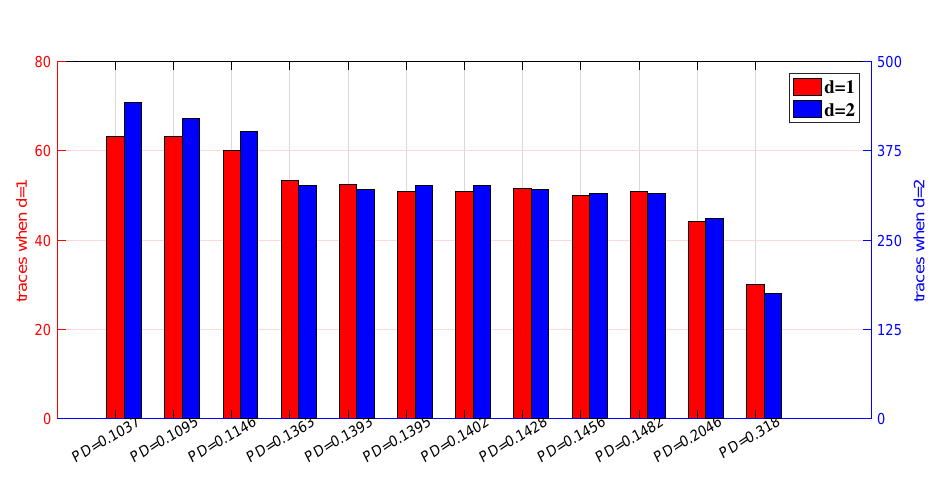
Figure 3: Number of traces for GE to be below 4 (in y-axis) versus the different PD (in x-axis) for n = 6 and σ = 0 .